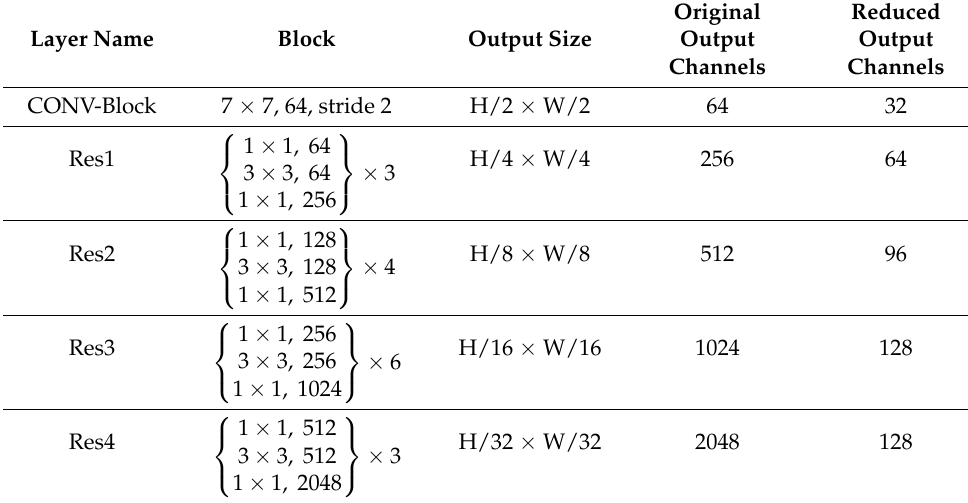
Table 1. Encoder details of the ResNet-50.